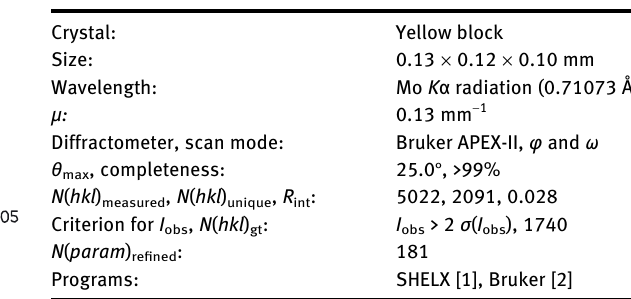
Table  : Data collection and